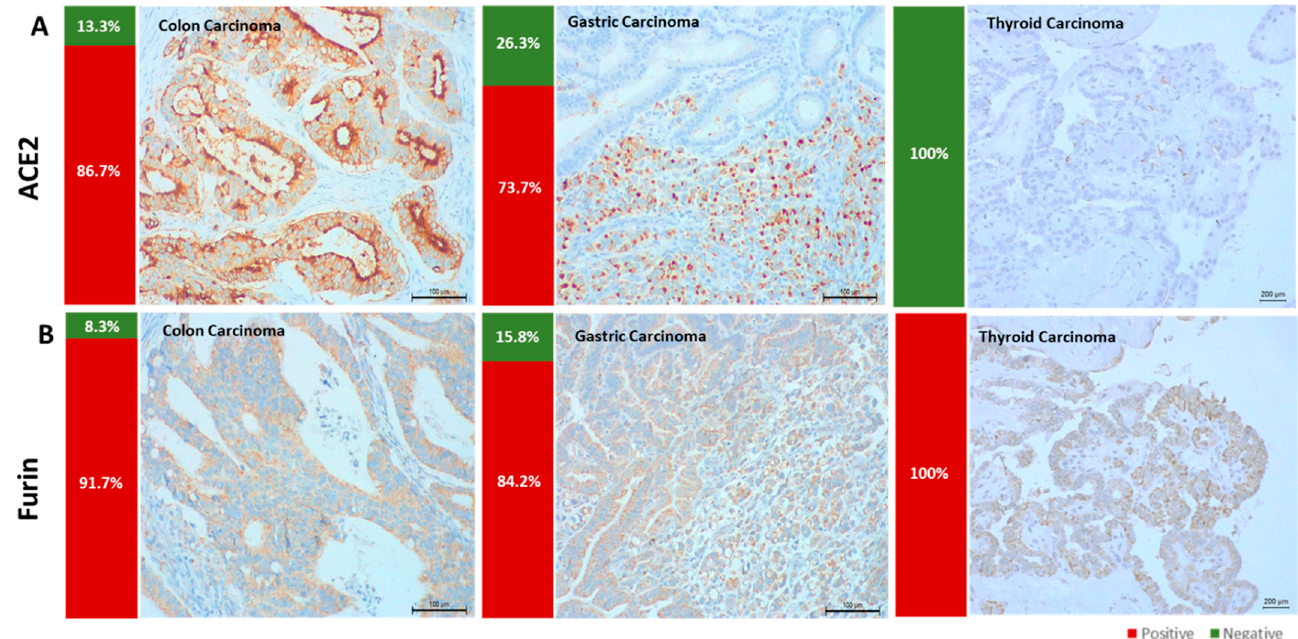
Figure 1. ACE2 and furin expressions in colon, gastric, and thyroid carcinomas. ( A ) ACE2 was highly expressed in colon and gastric carcinomas but not expressed in thyroid tumors. ( B ) Furin was expressed in all carcinoma types evaluated.